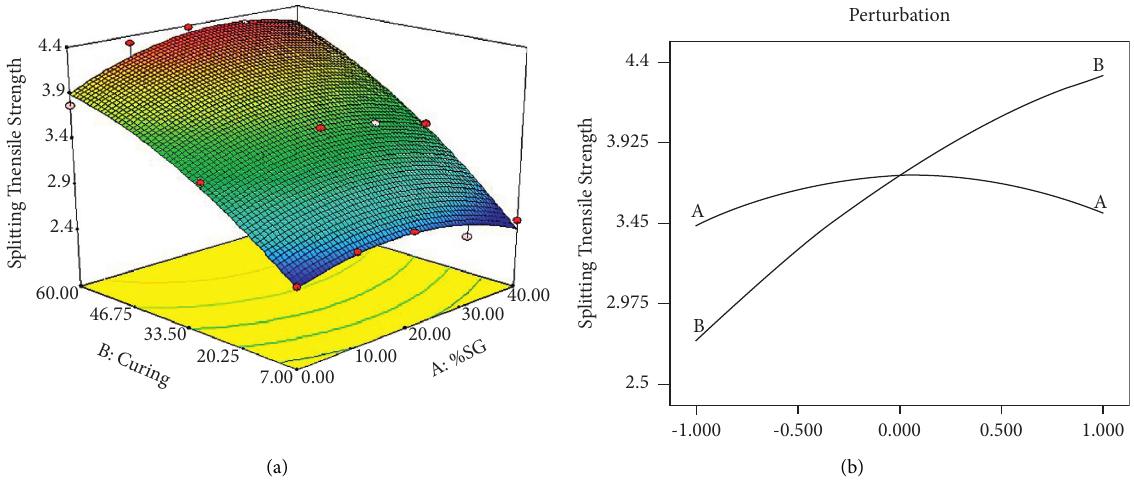
Figure 14: Response surface plots (a) and perturbation plots (b) indicating the relationship between spent garnet content and curing days with respect to splitting tensile strength.